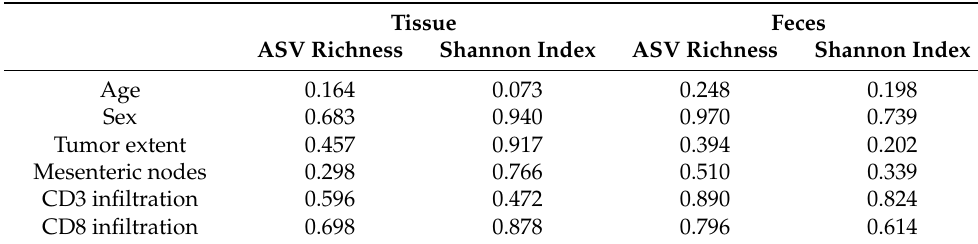
Table 2. Fecal and tissue microbiota alpha diversity associations ( p -values) with tumor extent, mesenteric lymph nodes, and T cell infiltration.